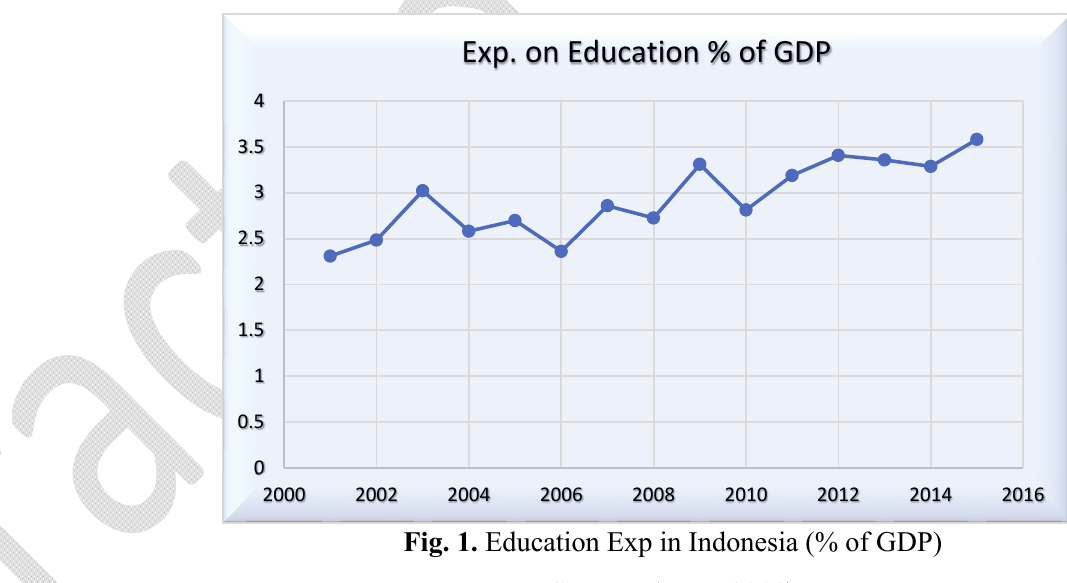
Fig. 1. Education Exp in Indonesia (% of GDP) Source : (WDI,